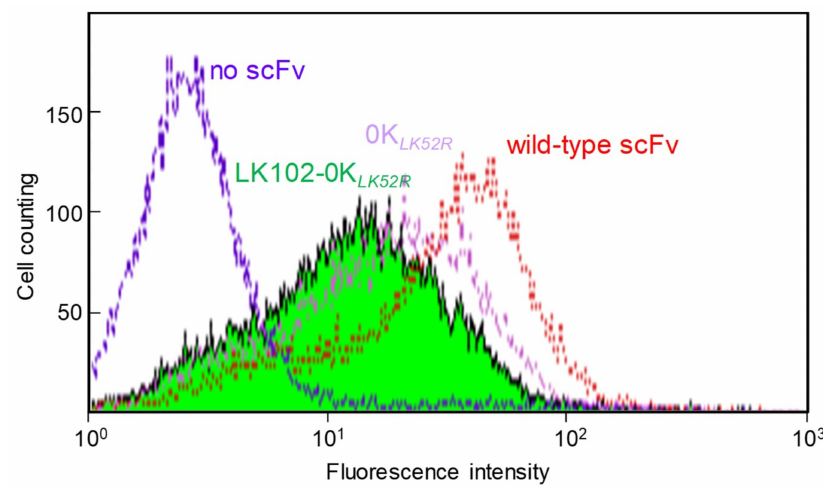
Figure 2. Flow cytometry histogram of T-LAK cells measured with flow cytometry. 10 6 Cells were incubated with 0K LK52R and LK102-0K LK52R hOKT3 scFvs labeled with FITC-labeled anti-c-myc’ IgG antibody, and they were analyzed by means of flow cytometry (purple and filled green, respectively). Cells incubated with wild-type scFv and without wild-type scFv were also analyzed by FITC-labeled anti-c-myc’ IgG antibody (red and navy blue, respectively).